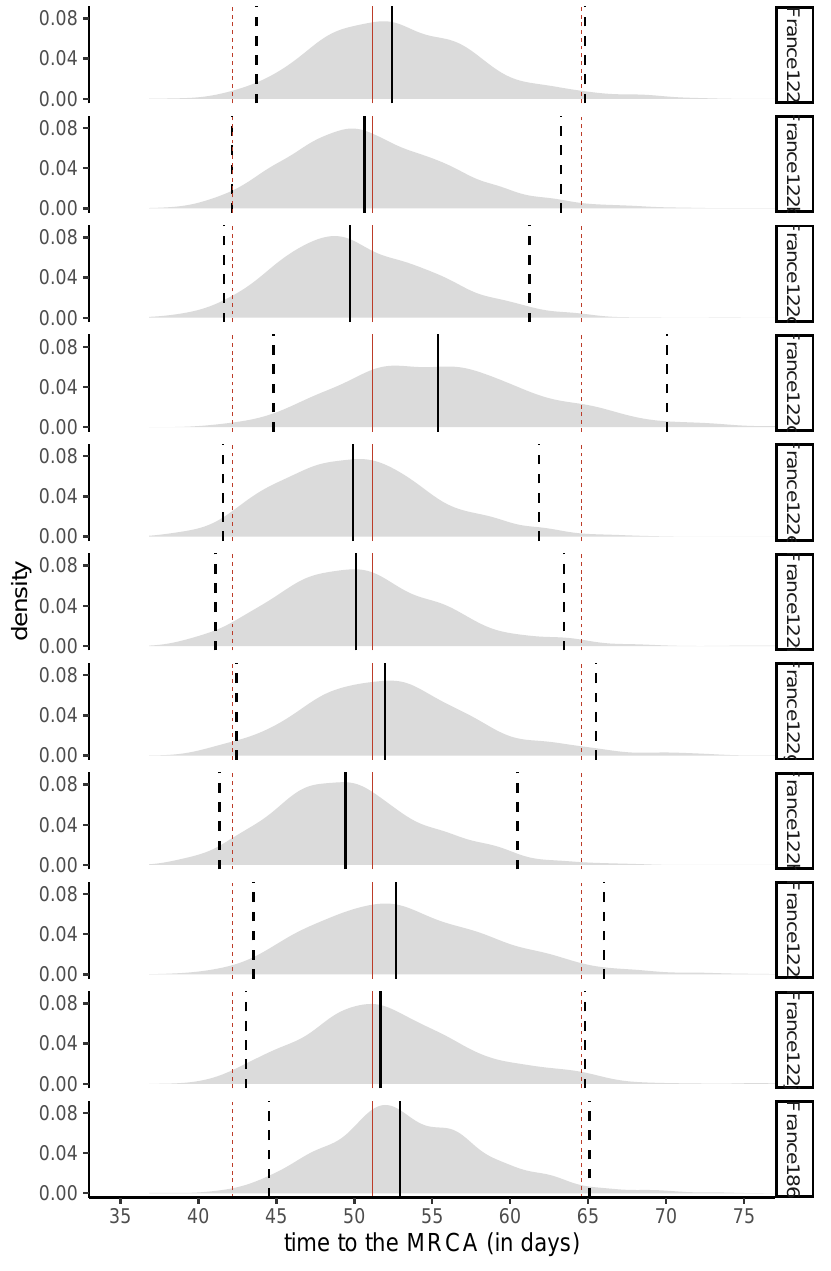
Figure S5 – Time to the MRCA for the France186 dataset and subsets with 122 sam- pled sequences assuming an exponential growth coalescent model. The red lines show the quantiles (0.025, 0.5, and 0.975) for the average of the 10 datasets. The black line shows the quantile for each dataset, and we can see how it behaves compared to the average. The last panel shows the largest phylogeny built without sampling, i.e. using all 186 sequences. The latter phylogeny has a slightly larger number of days to the